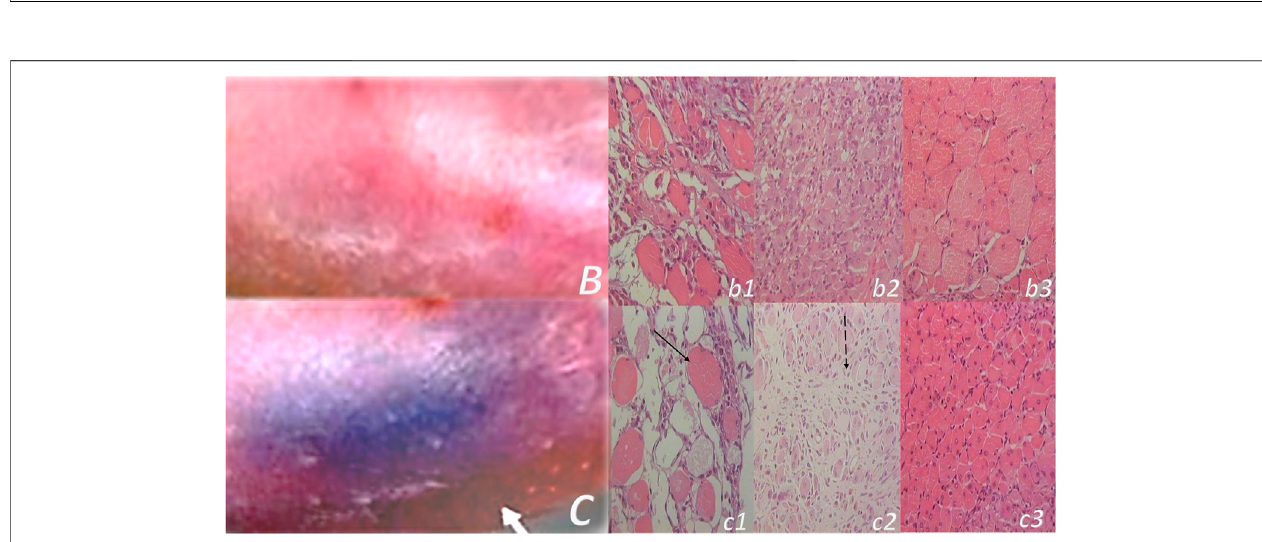
FIGURE10| MusclecrushinjuryandBPC157therapy(Novinscaketal.,2008;Pevecetal.,2010).Forcedeliveredwasof0.727 Ns/cm 2 (impulseforce0.4653 Ns, kinetic energy 0.7217 J), to a maximum diameter of gastrocnemius muscle complex (GMC), about 2 cm proximal to the insertion of the Achilles tendon. Regimens with similar effectiveness included (i) BPC 157 dissolved in saline (10 μ g, 10 ng/kg body weight), (ii) pentadecapeptide BPC 157 in neutral cream (1.0 or 0.01 μ g dissolved in distilled water/g commercial neutral cream). Controls received saline (5.0 ml/kg) applied intraperitoneally and or commercial neutral cream applied as a thin cream layer at the site of injury. All animals were treated only once, immediately after injury, if killed and assessed after 2 h. Alternatively, the animals were treated once daily, receiving a fi nal dose 24 h before death and/or assessment (walking, muscle function, and a macroscopic analysis) at days 1, 2, 4, 7, and 14. Gross posttraumatic hematoma presentation at 2 h after injury induction ( C -control (white arrow), B -BPC 157 rats (thin cream layer at the site of the injury immediately after injury induction)). Microscopy assessment ( c1, b1 (postinjury day 4) , c2, b2 (postinjury day 7), and c3, b3 (postinjury day 14)). HE, x10. Controls. Severe atrophy with severe reduction of myocytes (black arrow) and no regeneration attempt, pronounced perimyocytic edema (postinjury day 4, c1 ); scarce to moderate regeneratory attempts in muscle with maturing granulation tissue (dashed black arrow) (postinjury day 7, c2 ); pronounced regeneration with a high number of smaller myocytes and some areas of scarring (postinjury day 14, c3 ). BPC 157. Clearly visible regenerative activity and less edema (postinjury day 4, b1 ); fl orid regenerative activity in myocytes with high number of relatively small myocytes and no scarring (postinjury day 7, b2 ); well-regenerated myocytes of appropriate size and very little scarring (postinjury day 14, b3 ).